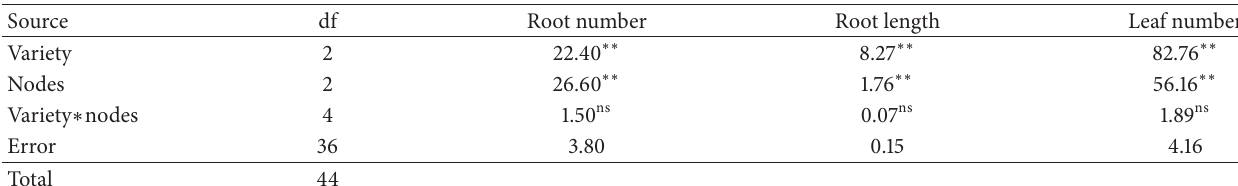
Table 4: Mean square from analysis of variance for root number, root length, and leaf number on day 14.